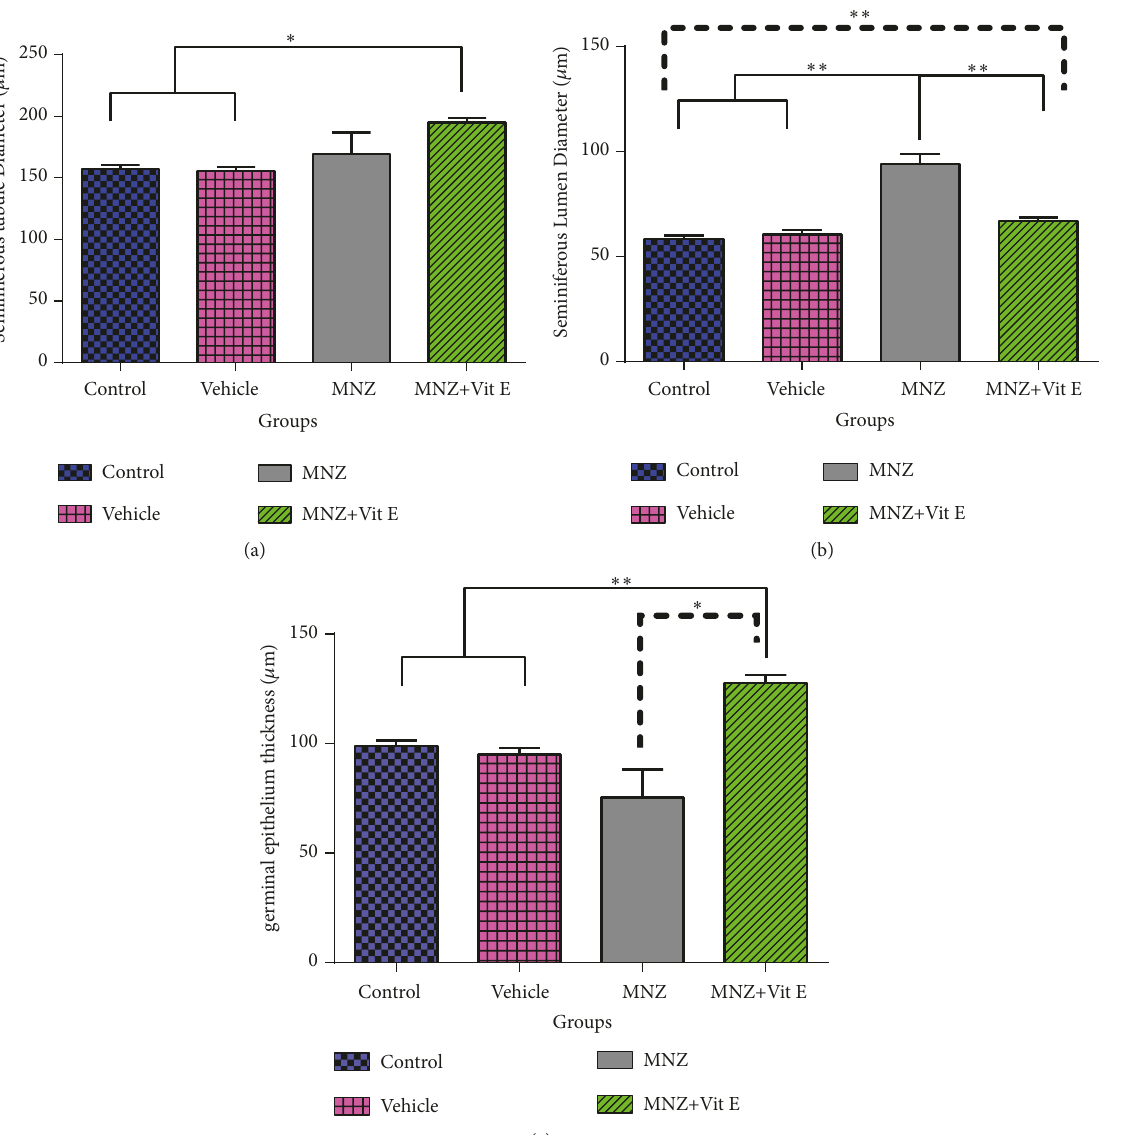
Figure 5: The effect of mancozeb administration alone and with vitamin E during intrauterine life and lactating periods on testis structure; seminiferous tubule diameter (a), seminiferous lumen diameter (b), and germinal epithelium thickness (c) in the different groups (n=7). MNZ: mancozeb. ∗ and ∗∗ indicate p < 0.05 and p < 0.01,